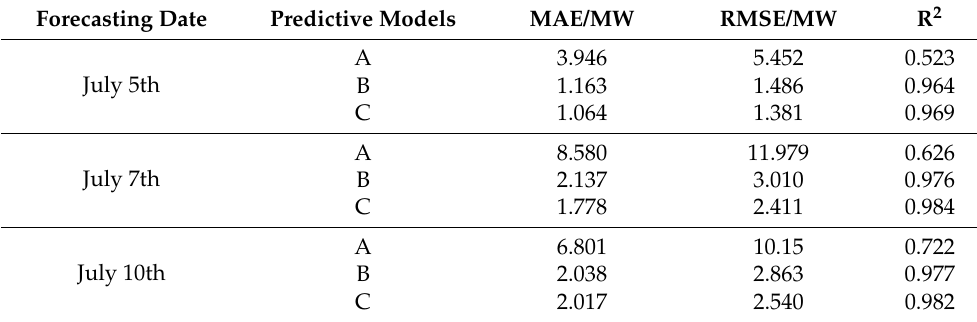
Table 6. Error evaluation indices of each prediction